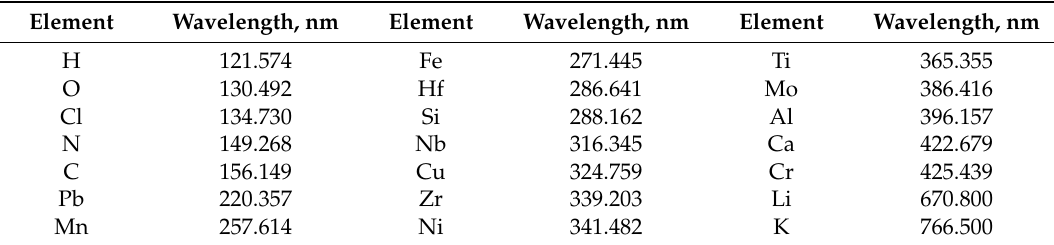
Table 2. Analytical emission lines